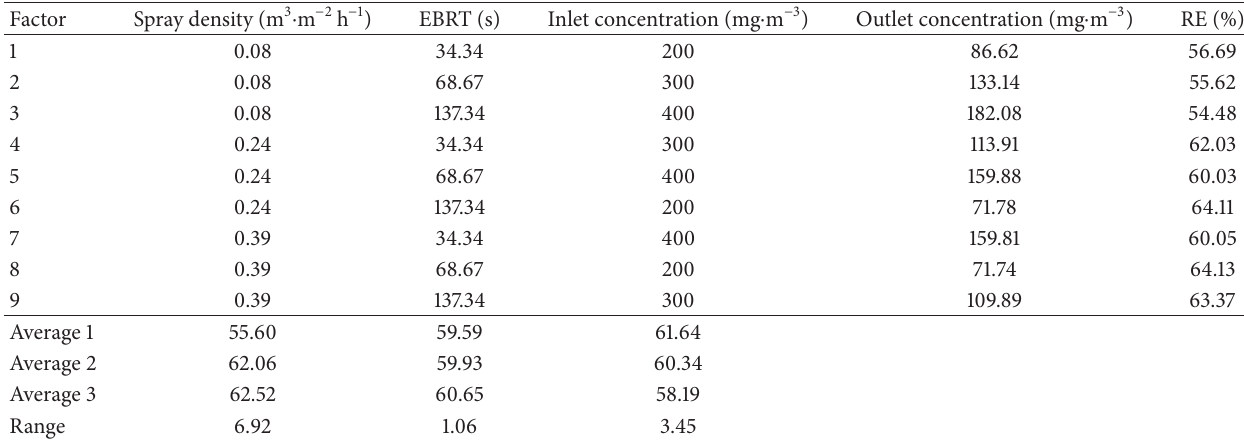
Table 1: The result of orthogonal